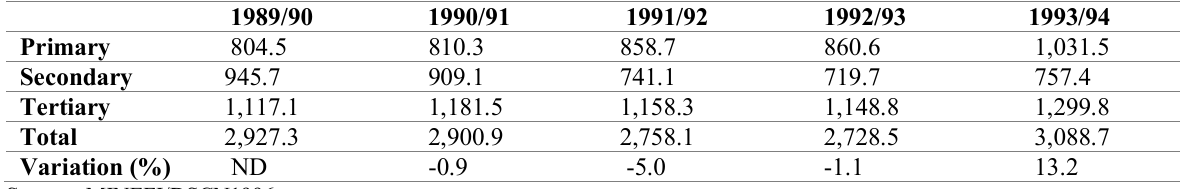
Table 1 : Change in GDP by Activity Groups in Cameroon (billions of CFA francs)